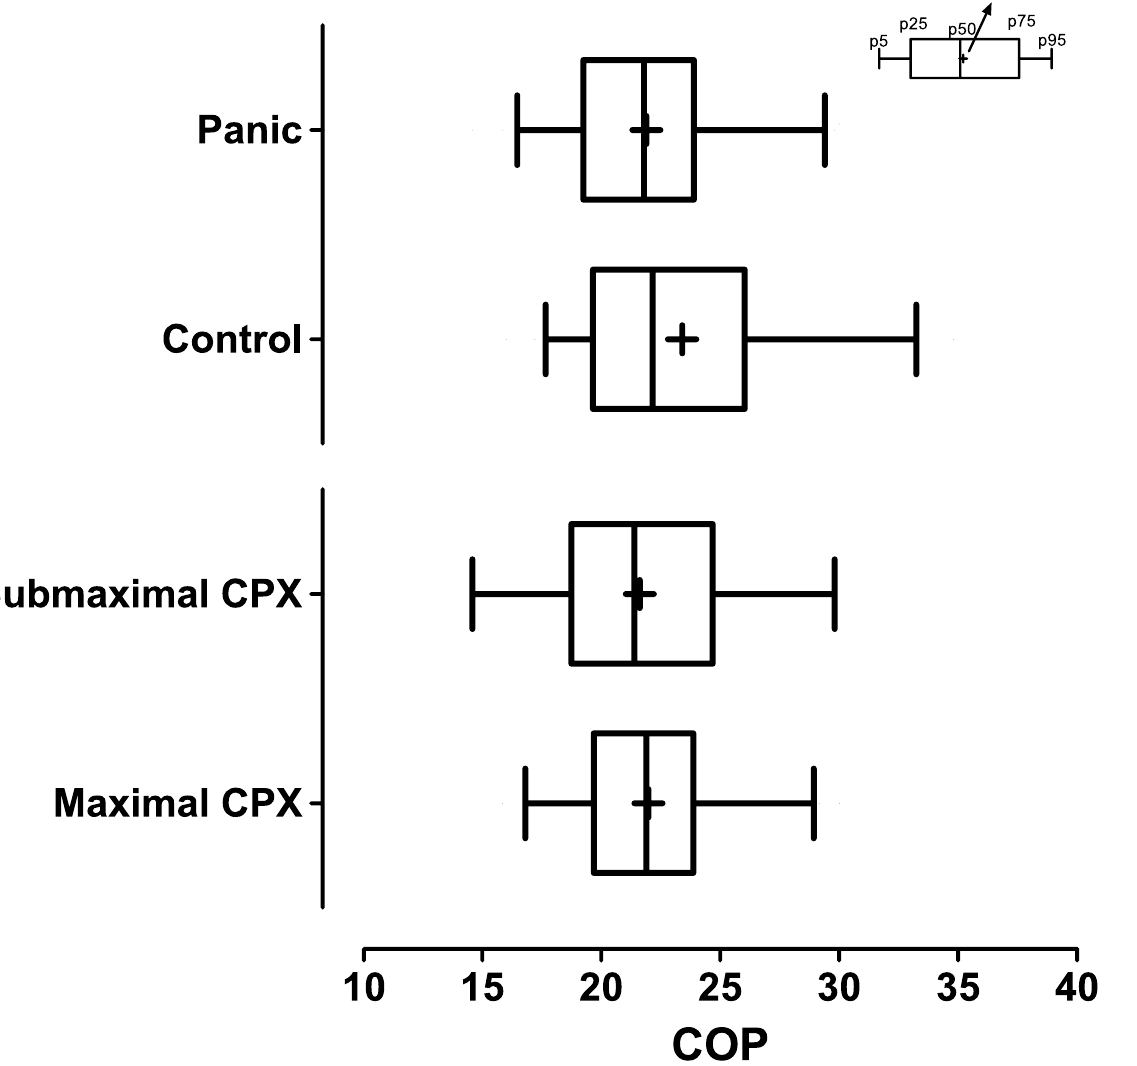
Figure 1. Comparison of COP for the control and PD groups and for the subgroups MAX and SUBMAX of patients with PD. * p , 0.05.